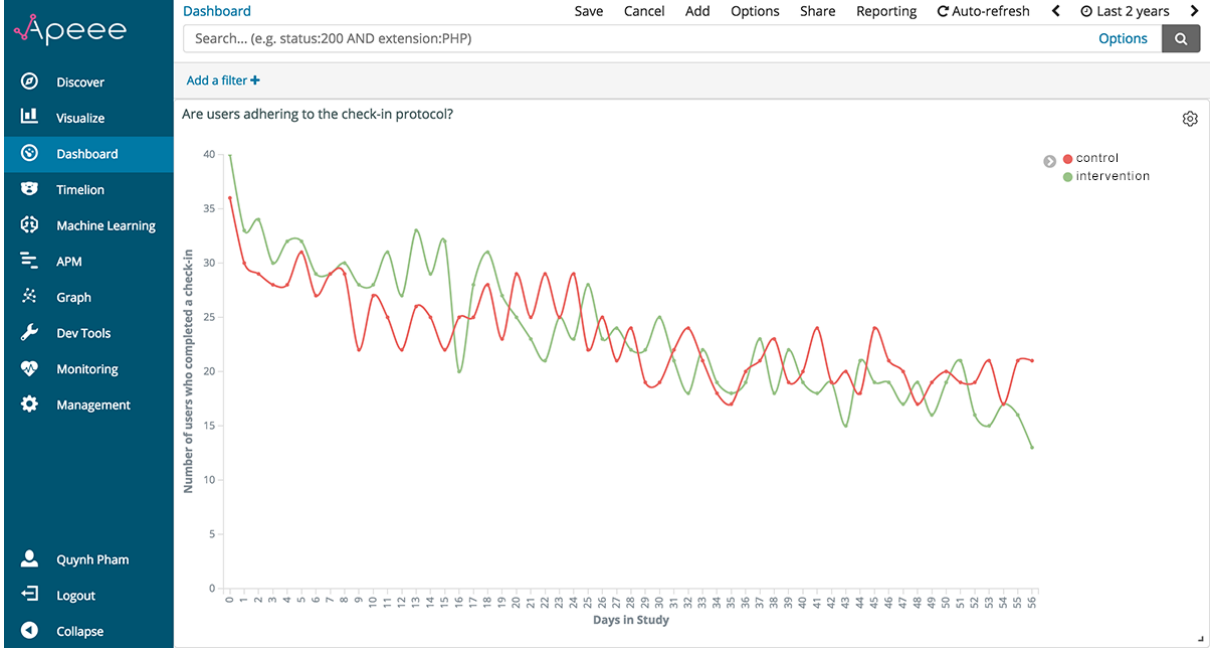
Figure 8. The analytic indicator for “are users adhering to the check-in protocol?,” visualized through APEEE as a line graph. APEEE: Analytics Platform to Evaluate Effective